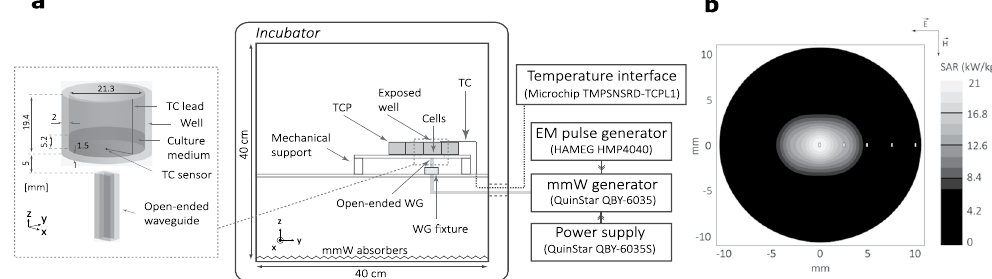
Figure 1. ( a ) Outline of the exposure setup. Cells located at the bottom of a well of a 12-well TCP were exposed by an open-ended WG inside the incubator at 32 °C (center). CAD model of the antenna and exposed well were used for computing SAR (left). Continuous wave and pulsed signals were generated at 58.4 GHz by a customized MMW generator controlled by an electromagnetic pulse generator. The temperature was monitored using a TC through a dedicated interface (right). ( b ) Computed SAR in the cell monolayer normalized to the antenna input power of 1W. White ellipses indicate the locations of TC sensors in temperature